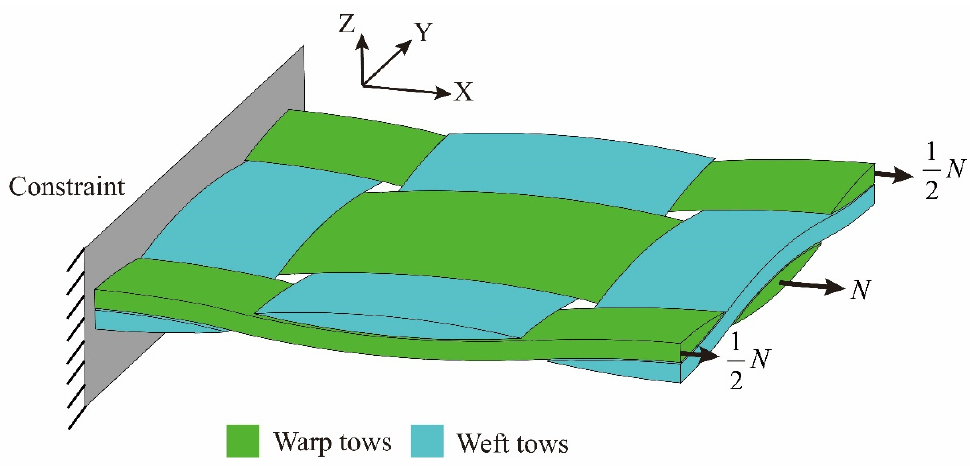
Figure 7. The part composed of fiber tows in the mesoscale RUC of the plain-woven fabric composites. With the above deductions, the proposed analytical model for the uniaxial tensile